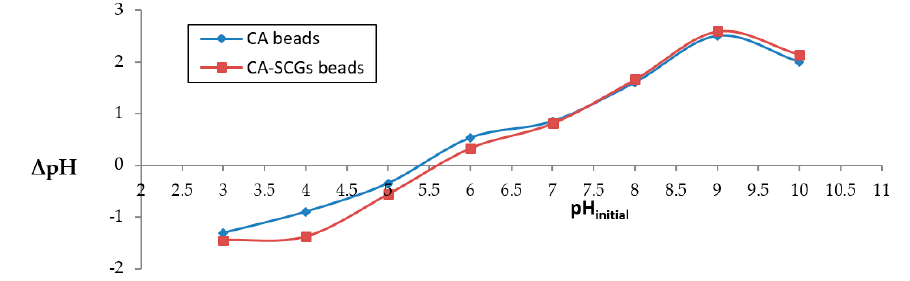
Figure 1. Determination of pH pzc using pH drift method.